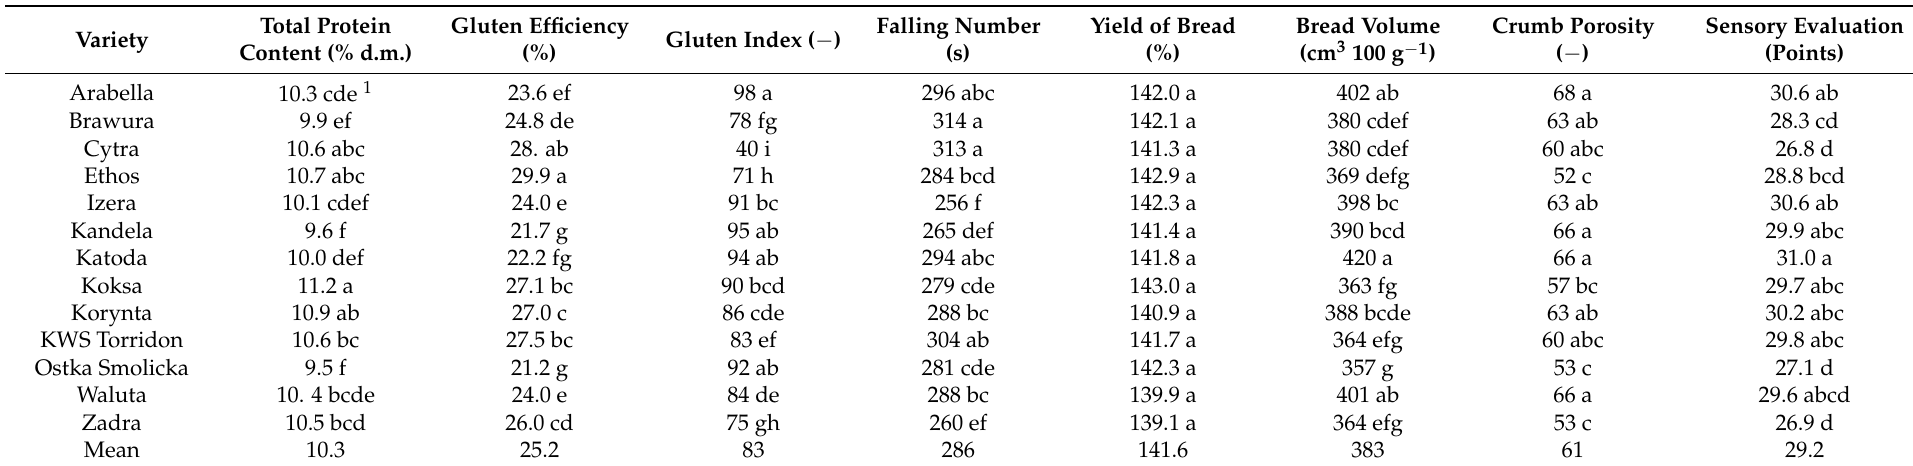
Table 8. Results of the evaluation of the baking value of flour (averages over